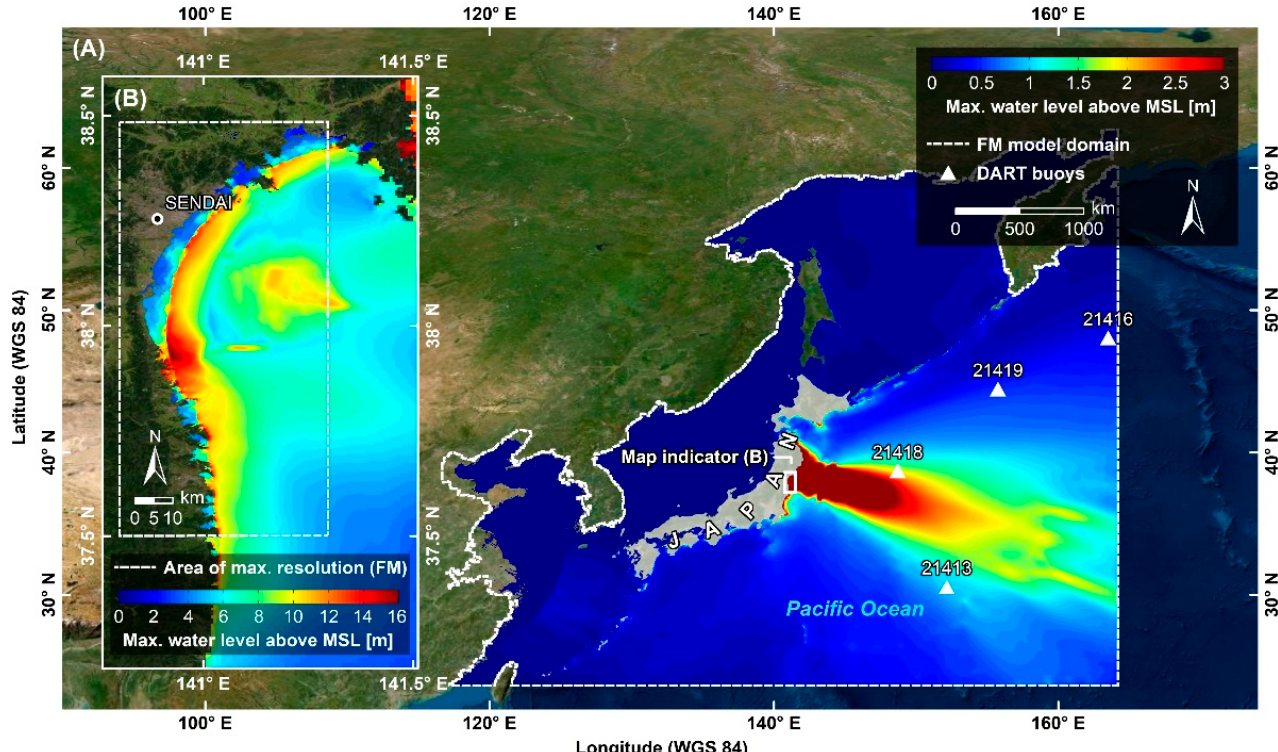
Figure 3. Maximum water levels above mean sea level (MSL) simulated for the 2011 T¯ohoku tsunami with the all-in-one D-FLOW Flexible Mesh (FM) model for the north-western Pacific Ocean ( A ) and for the Sendai Bay ( B ). Figure 4A indicates a similar order and spatial pattern of simulated maximum water levels in the north-western Pacific Ocean for the case of the overall SFINCS model. However, the beaming of tsunami wave energy is more pronounced resulting in higher water levels along the main axis of tsunami propagation. In the Sendai Bay, the simulated maximum water levels are slightly below the predictions by the FM model (Figure